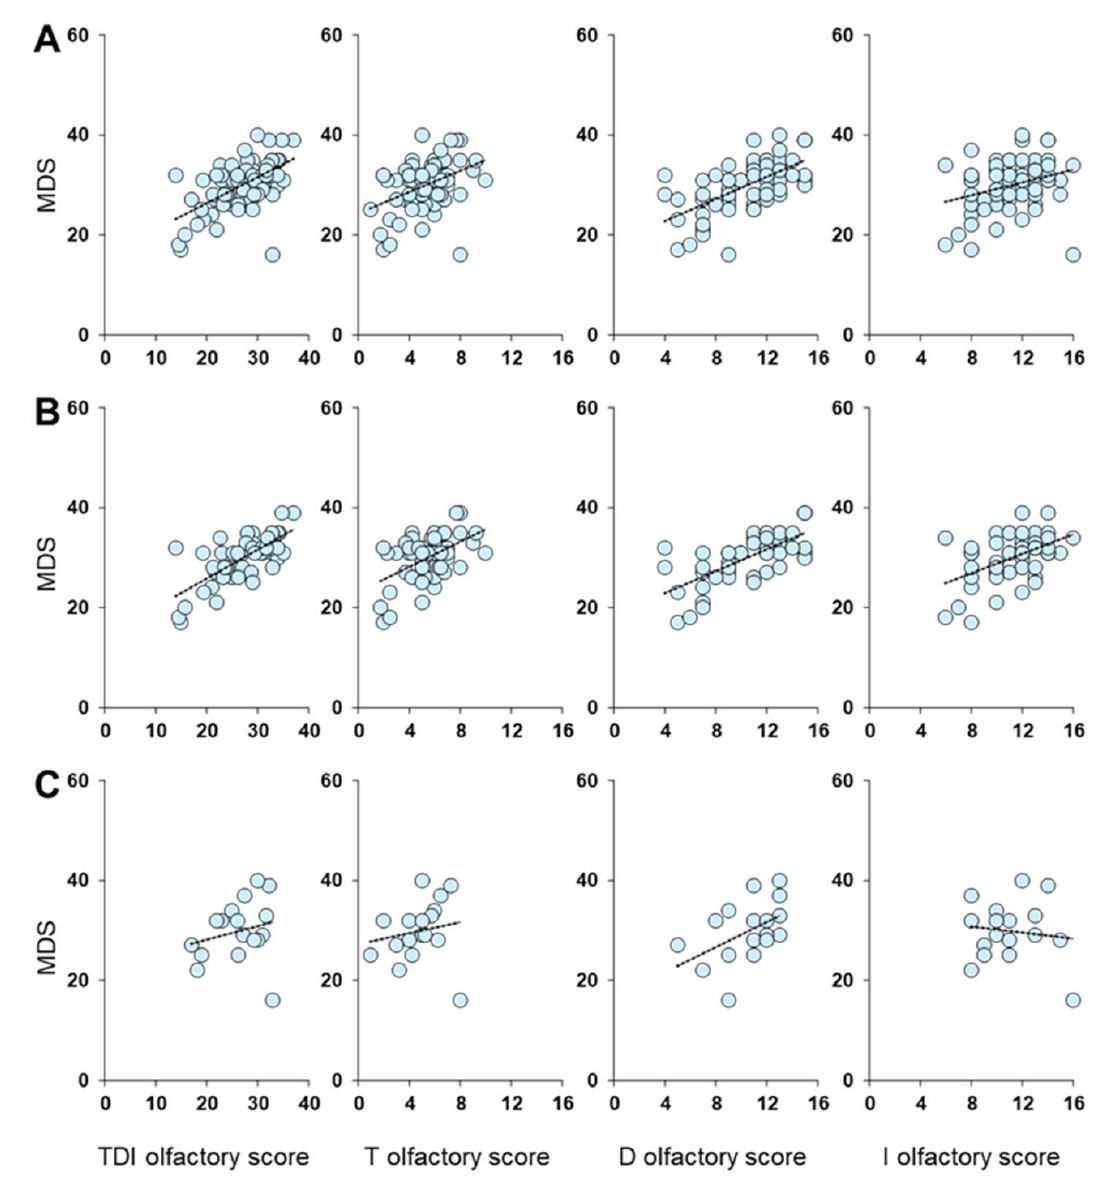
Figure 5. Correlation analysis between olfactory scores obtained by each patient and his/her Mediterranean Diet Score (MDS) in the whole sample ( A ), and in females ( B ) and males ( C ), separately.